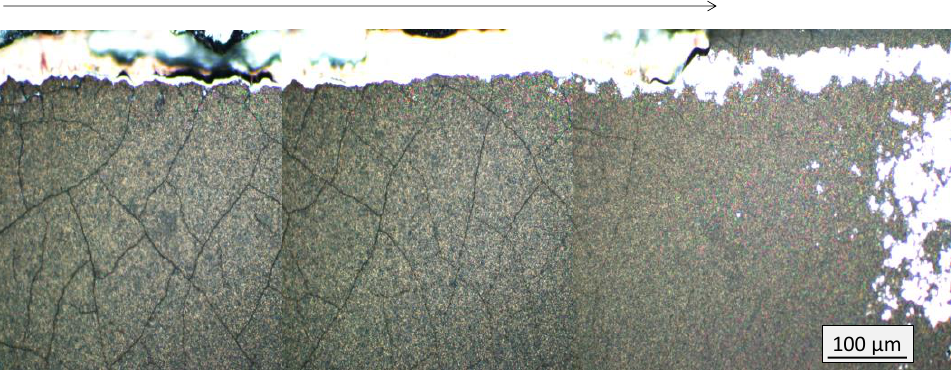
Figure 3. Worn edge after milling (5 surfaces) for the Zr(C,N)/α-Al 2 O 3 system. The expanded crack network in the contact region with the workpiece is clearly visible.